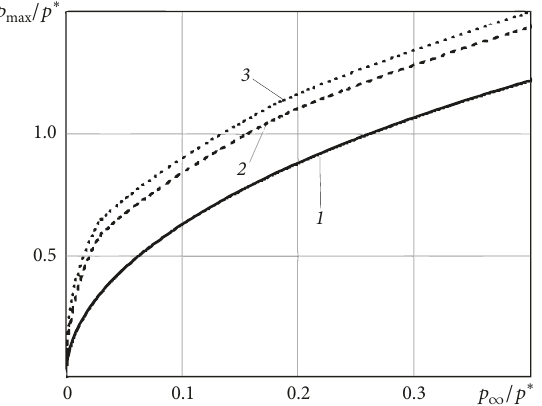
Figure 6: Dimensionless maximum pressure as a function of dimensionless mean pressure for different profiles ( 𝜆 1 = 2 𝜋 , Δ 1 = 0.5): f ( x ) = Δ 1 cos (𝑥) ( 1 ); f ( x ) = Δ 1 cos (𝑥) +0.02 Δ 1 cos (11𝑥) ( 2 ); f ( x ) = Δ 1 cos (𝑥) +0.02 Δ 1 cos (11𝑥) +0.0015 Δ 1 cos (40𝑥) ( 3